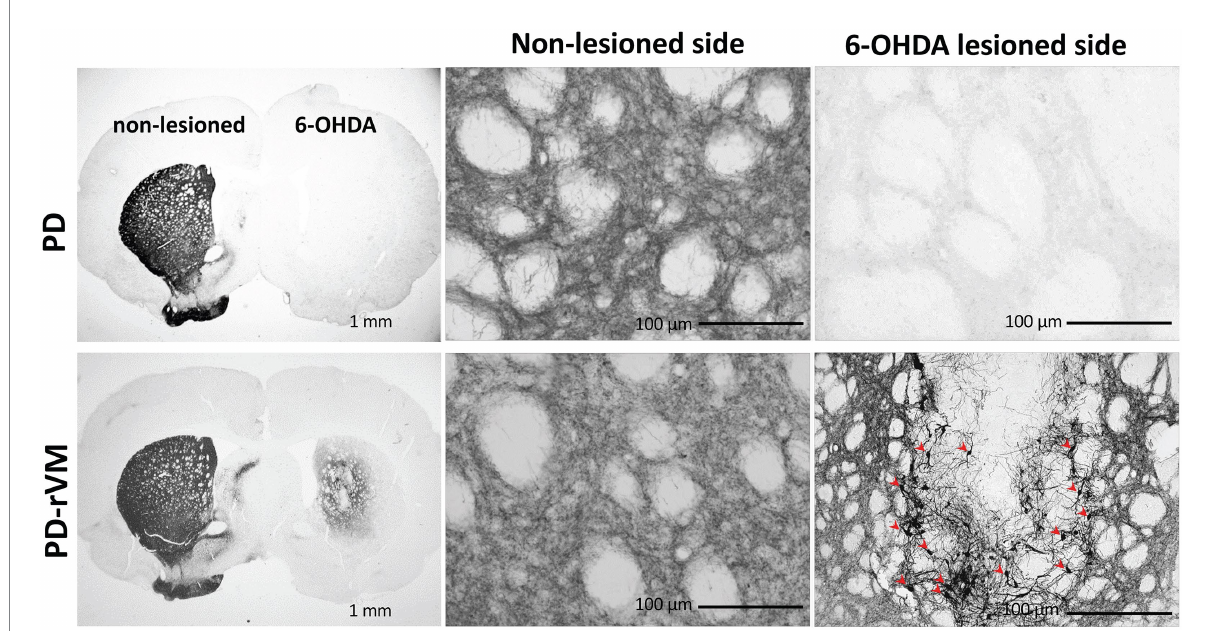
FIGURE 7 Tyrosine hydroxylase immunostaining in the brain of PD rats. In the PD group, the 6-OHDA-lesioned side exhibited much lower TH immunoreactivity than the unlesioned side. In contrast, cell transplantation significantly increased TH immunoreactivity in the PD-rVM group. The TH-positive cells in the striatum on the 6-OHDA-lesioned side of from the PD-rVM group are indicated by red arrows (lower right